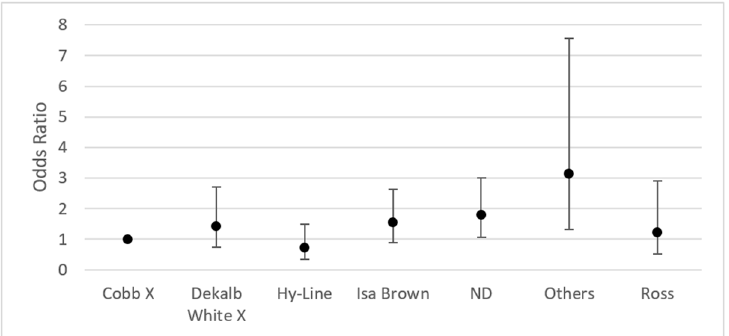
Figure 4. Odds ratio by breed (95% CI) of positive isolates for fungi in chicken lungs ( Gallus gallus ) from 2008 to 2021 in the Mycology Laboratory, School of Veterinary Medicine, Universidad Nacional, Heredia, Costa Rica. Cobb X = pure Cobb mixed with Hubb and Ross; Dekalb White X = pure Dekalb White mixed with Isa Brown; ND = non-determinate breed; Others = Redbro, Sasso, Hubbard, and Lohman.